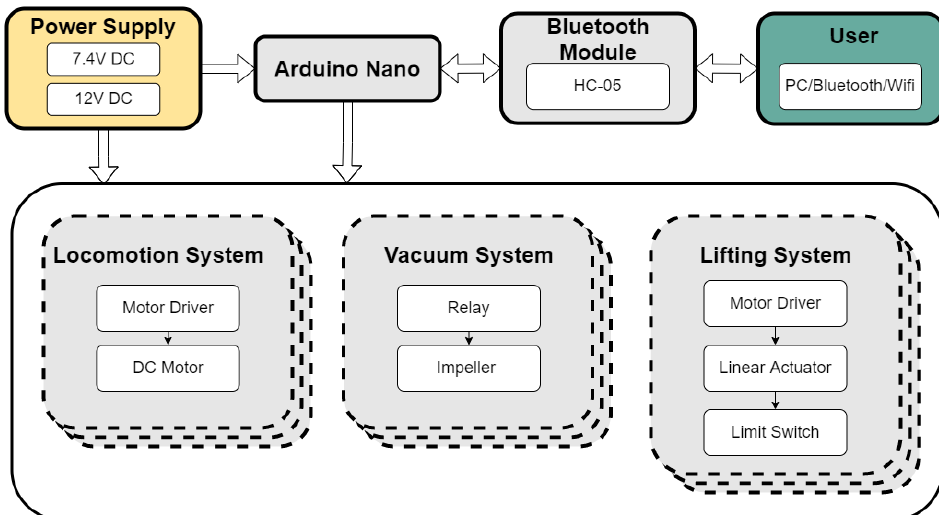
Figure 5. Electronics block diagram of